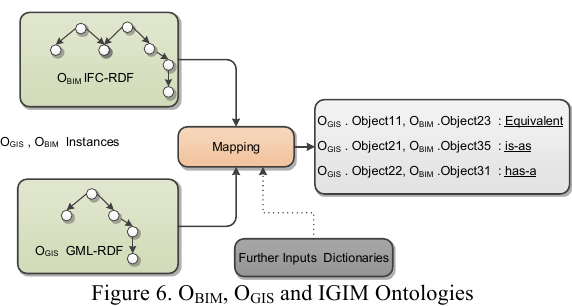
Figure 6. O BIM , O GIS and IGIM Ontologies